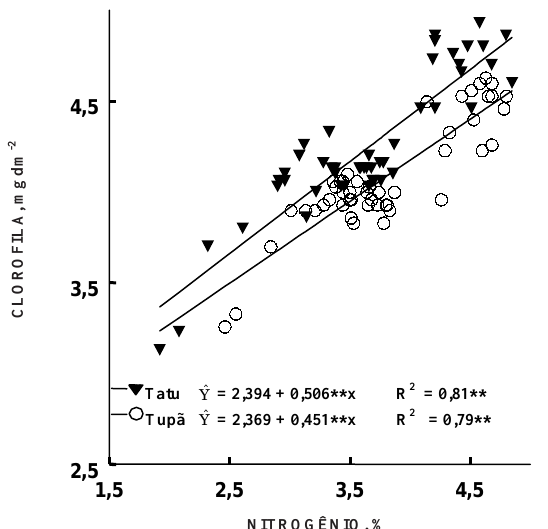
Figura 1. Relações entre o teor de nitrogênio e a concentração de clorofila nas folhas de cultivares de amendoim. ** Significativo a 1%.